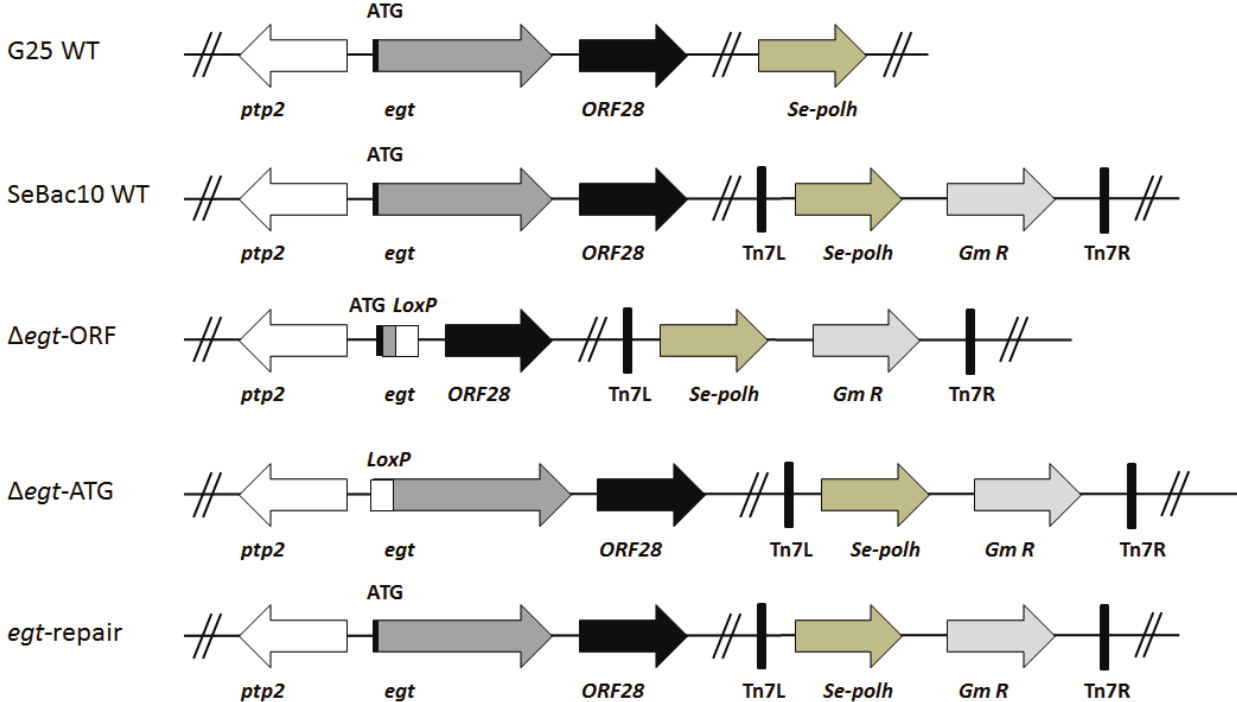
Figure 1. Overview of the recombinant bacmids used in this study. Two SeMNPV WT (G25 WT and SeBac10 WT) viruses were used: G25 WT is a naturally occurring strain and SeBac10 WT is a bacmid derived from the SeMNPV US1 strain. Using the SeBac10 WT bacmid, two SeMNPV mutants (Δ egt - ORF and Δ egt - ATG) were made: in Δ egt -ORF, a major part of the egt ORF was replaced by a fragment containing a mutant loxP site (used to create the deletion); in Δ egt -ATG, only the start codon was replaced by the fragment with the loxP site. An egt -repair bacmid was also constructed. For all bacmid-derived viruses (which lack the original polyhedrin gene), the Se-polh gene and a gentamicin resistance gene ( Gm R ) were inserted into the genomes between the left and right insertion sites, indicated as Tn7L and Tn7R, present in the bacmid. Positions of neighbouring genes ( ptp2 : protein tyrosine phosphatase 2 and ORF28) of egt are indicated. After deletion of the target segments, the resulting bacmids were purified and used to transform E. coli DH10ΔTn7 cells carrying the transposition helper plasmid pMON7124 [25] (derived from E. coli DH10Bac ΔTn7 [26] by removing the original bacmid). To enable oral infection of S.